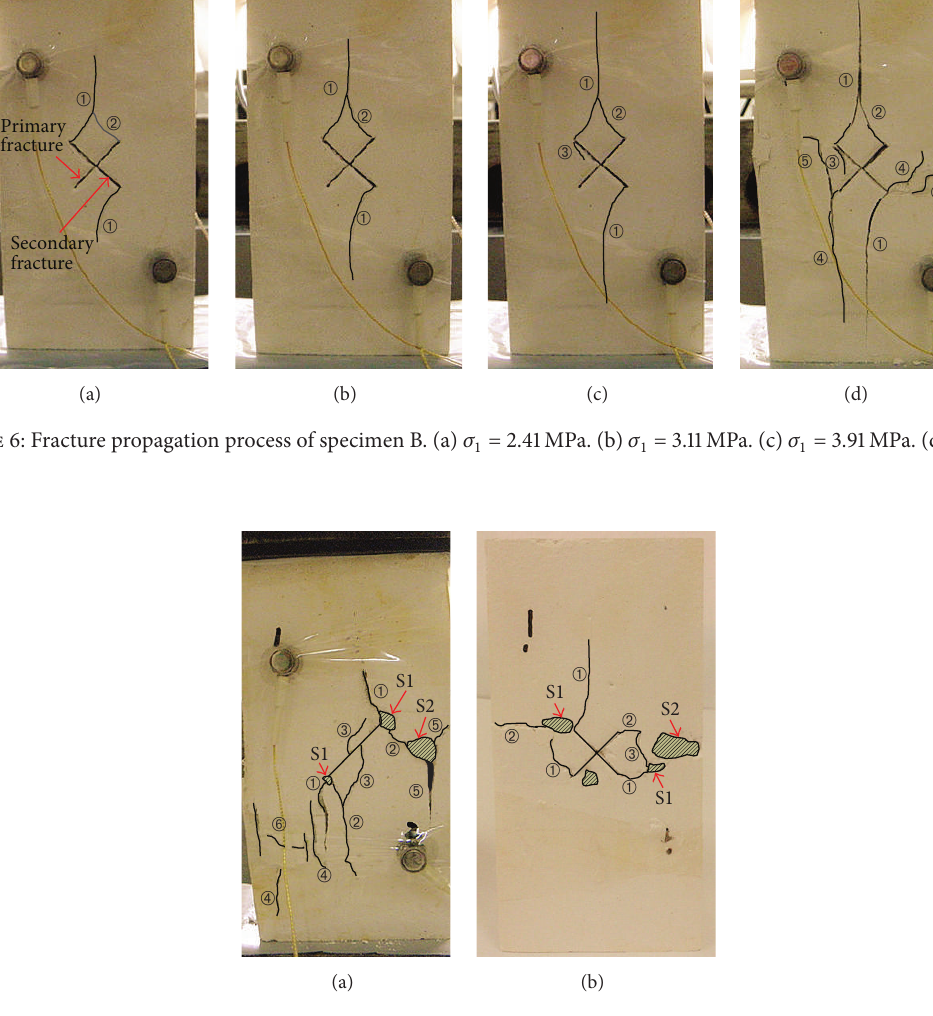
Figure 7: Failure modes of specimens under biaxial compression. (a) Specimen C. (b) Specimen